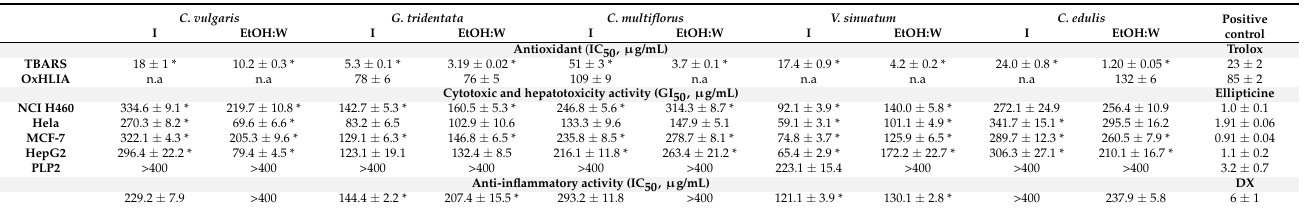
Table 2. Antioxidant, cytotoxic and anti-inflammatory activities of infusions and hydroethanolic extracts of selected